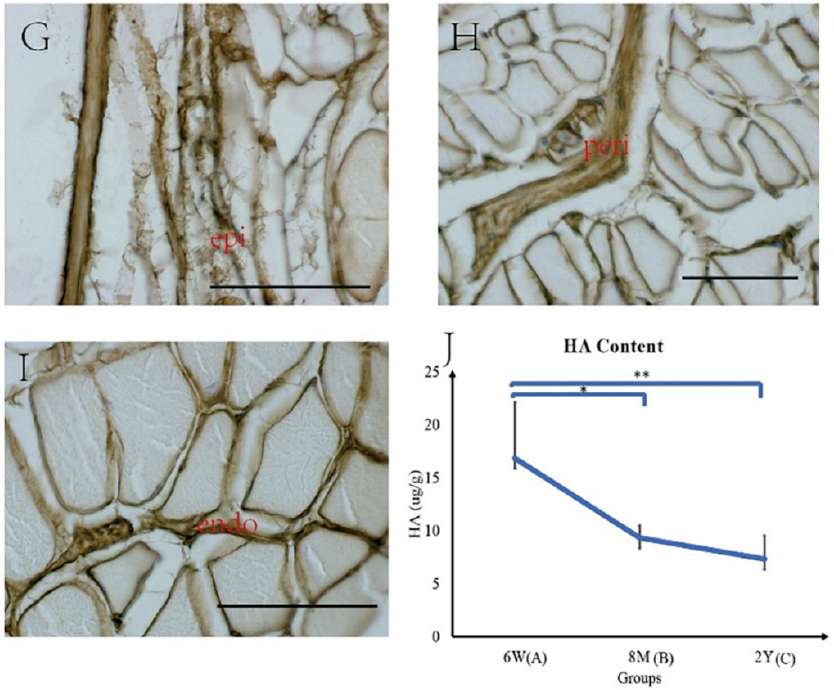
Figure 7. Alcian blue 0.05% with MgCl 2 0.05 M ( A ) and MgCl 2 0.3 M ( B ) of human muscle samples, and biotinylated HABP immunohistochemistry staining of the human ( C , D ) and mouse ( G – I ) muscle samples. epi: epimysium, peri: perimysium, endo: endomysium. Scale bars: 50 µ m. The Purple–Jelley HA assay showed the HA amount in human (( E ): young vs. elderly women, * p = 0.04; ( F ): elderly men vs. elderly women), and in the mouse skeletal muscle (( J ), * p < 0.05, ** p < 0.01). 6 W: 6 weeks old (Group A, puberty); 8 M: 8 months old (Group B, middle age); 2 Y: 2 years old (Group C,